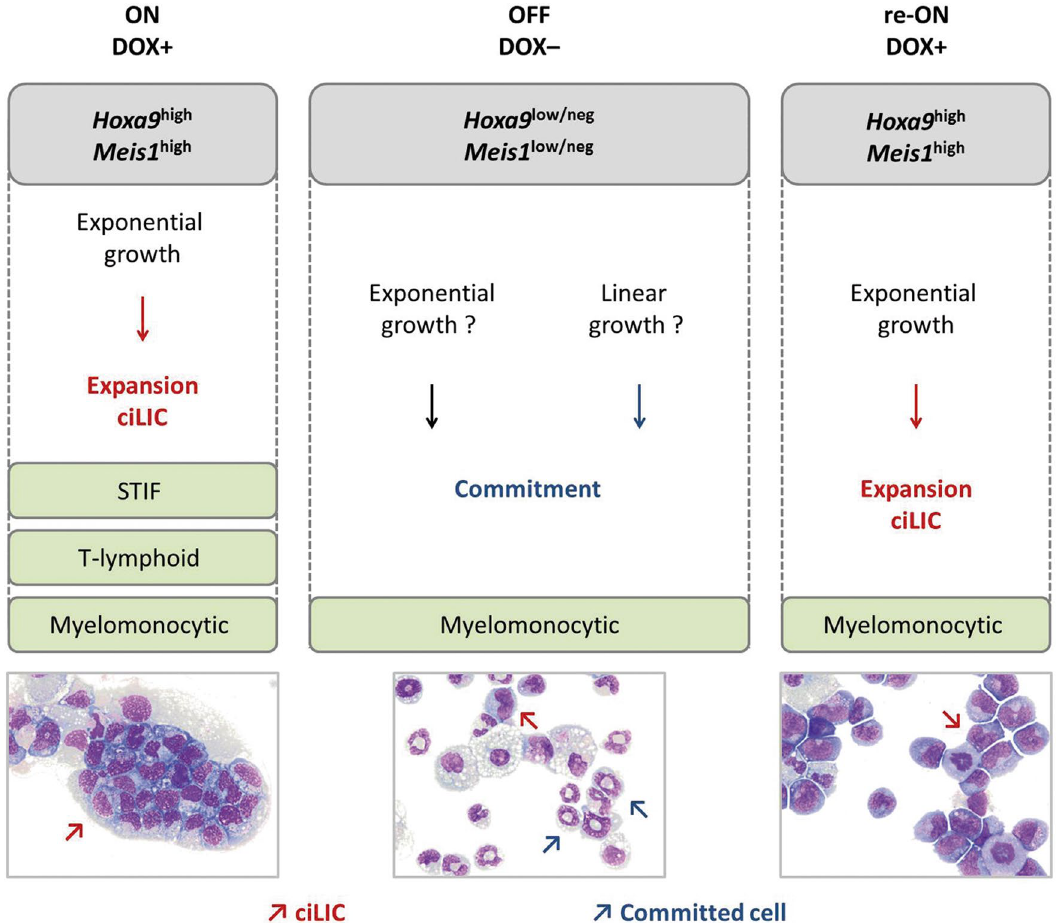
Figure 7. ciLICs co-expressing Hoxa9/Meis1 under different microenvironmental conditions ex vivo upon switching doxycycline ON/OFF/re-ON. Doxycycline (DOX) application (DOX+ , ON), removal (DOX-, OFF) reapplication (DOX+ , re-ON); ciLIC, conditionally immortalised leukaemia initiating cells; STIF, stem cell maintaining conditions; T-lymphoid, co-culture with OP9-DL1 stromal cells under T-lymphoid conditions; neg, negative . Red arrows indicate ciLICs; blue arrows indicate committed cells, e.g.